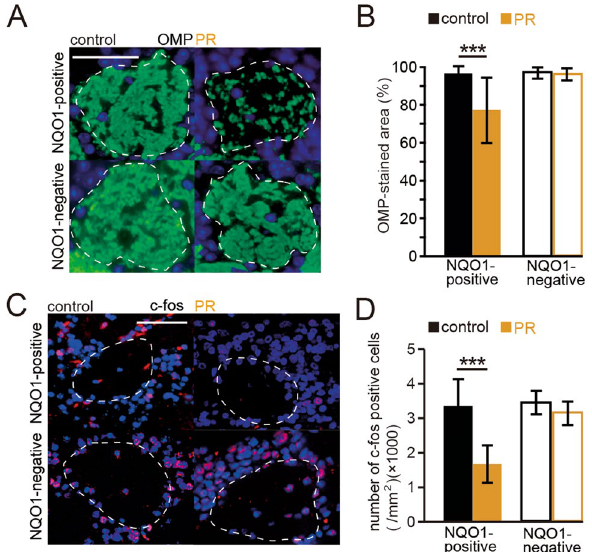
Figure 5. PR results in the projection of axons from fewer OSNs of zone 1. ( A ) Representative glomeruli (upper, NQO1-positive OB; lower, NQO1-negative OB) stained with anti-OMP antibody (green) from control and PR mice. Each circled area corresponds to a glomerulus. Scale 50 µm. ( B ) Summary of the ratio of areas stained with OMP. The OMP-stained area in the NQO1-positive OB of PR mice was significantly lower than that in control mice (***P < 0.001, Mann–Whitney test). However, the OMP-stained area did not differ according to condition in the NQO1-negative OB. ( C ) Representative coronal sections stained with anti-c-fos antibody in the NQO1-positive and NQO1-negative OB of control and PR mice. Aldehydes, lactones, and esters were selected as stimulus odorants to induce c-fos immunoreactivity in the OB neurons. Each circled area corresponds to a glomerulus. Scale 50 µm. ( D ) Comparison of the number of c-fos-positive cells between NQO1-positive and NQO1-negative OB in control and PR mice. The number of c-fos-positive cells (per mm 2 ) in the NQO1-positive OB of PR mice was significantly less than that in control mice (***P < 0.001, Mann–Whitney test), whereas in the NQO1-negative OB of PR mice, no significant difference was